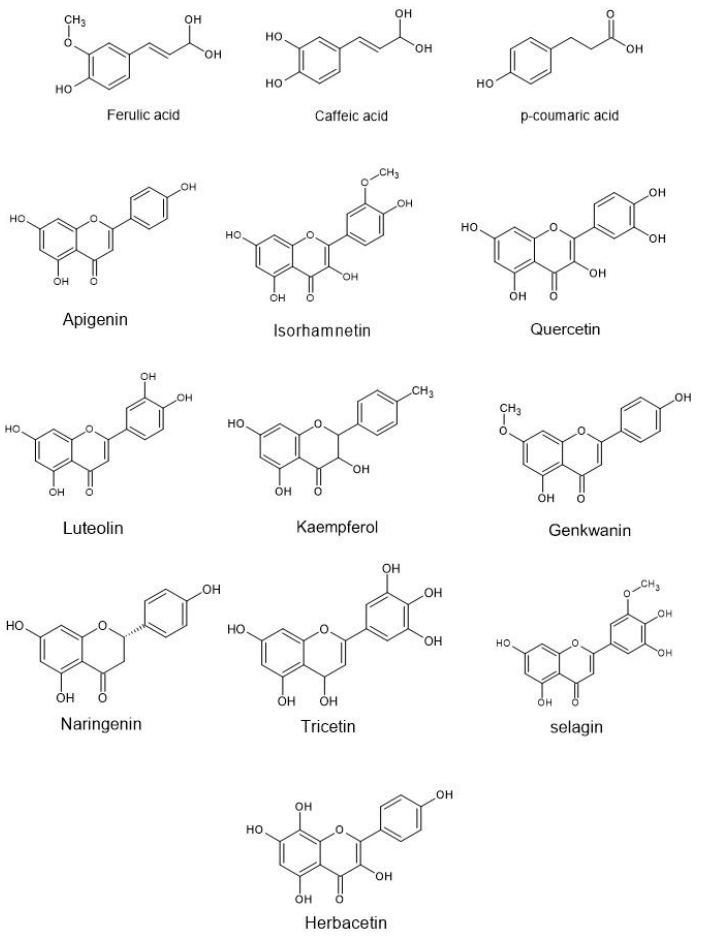
Figure 4. Chemical structures of some of the phenolic compounds found in stingless bee bee bread.